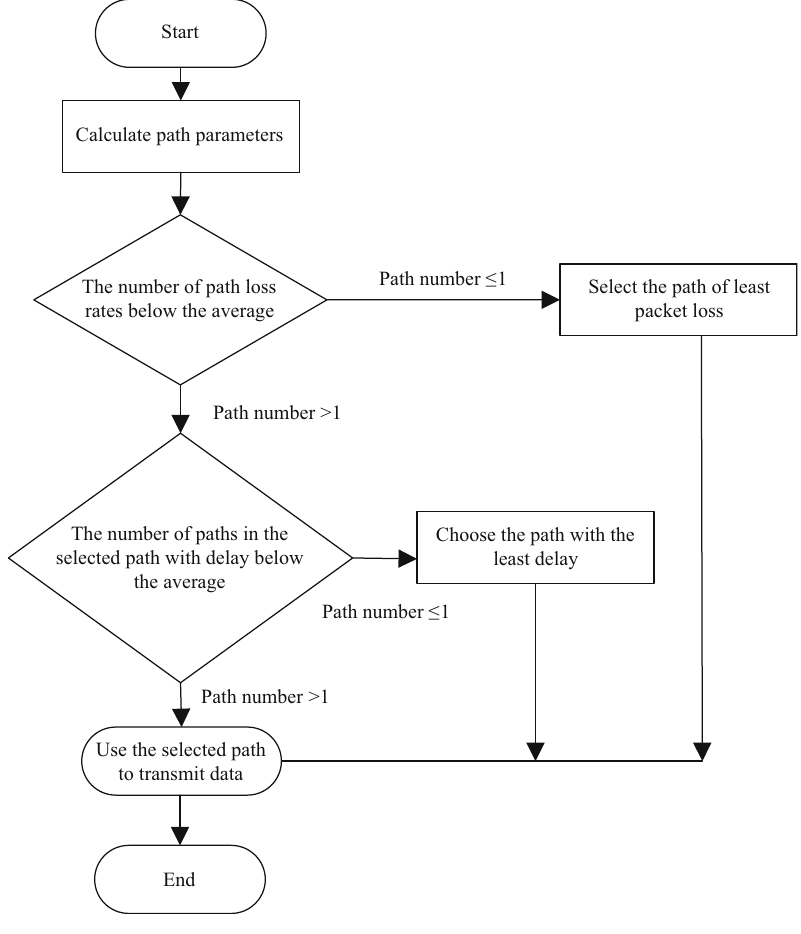
Figure 7: Flow chart of path